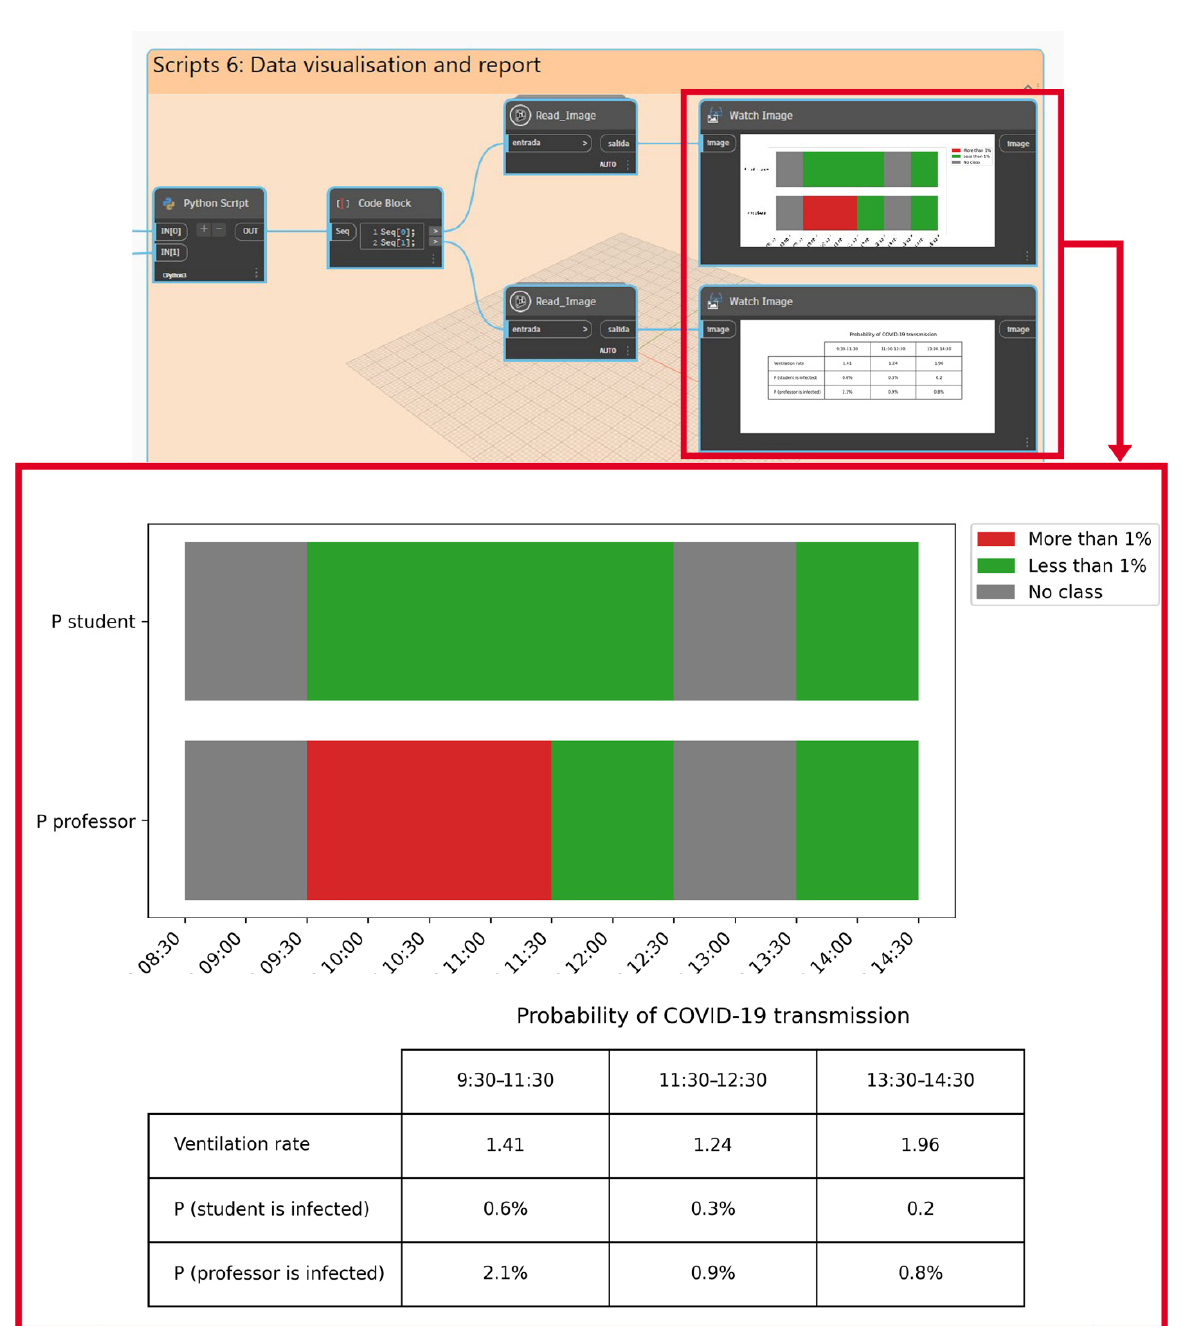
Figure 9. Assessment of the probability of airborne virus transmission in classroom 110.